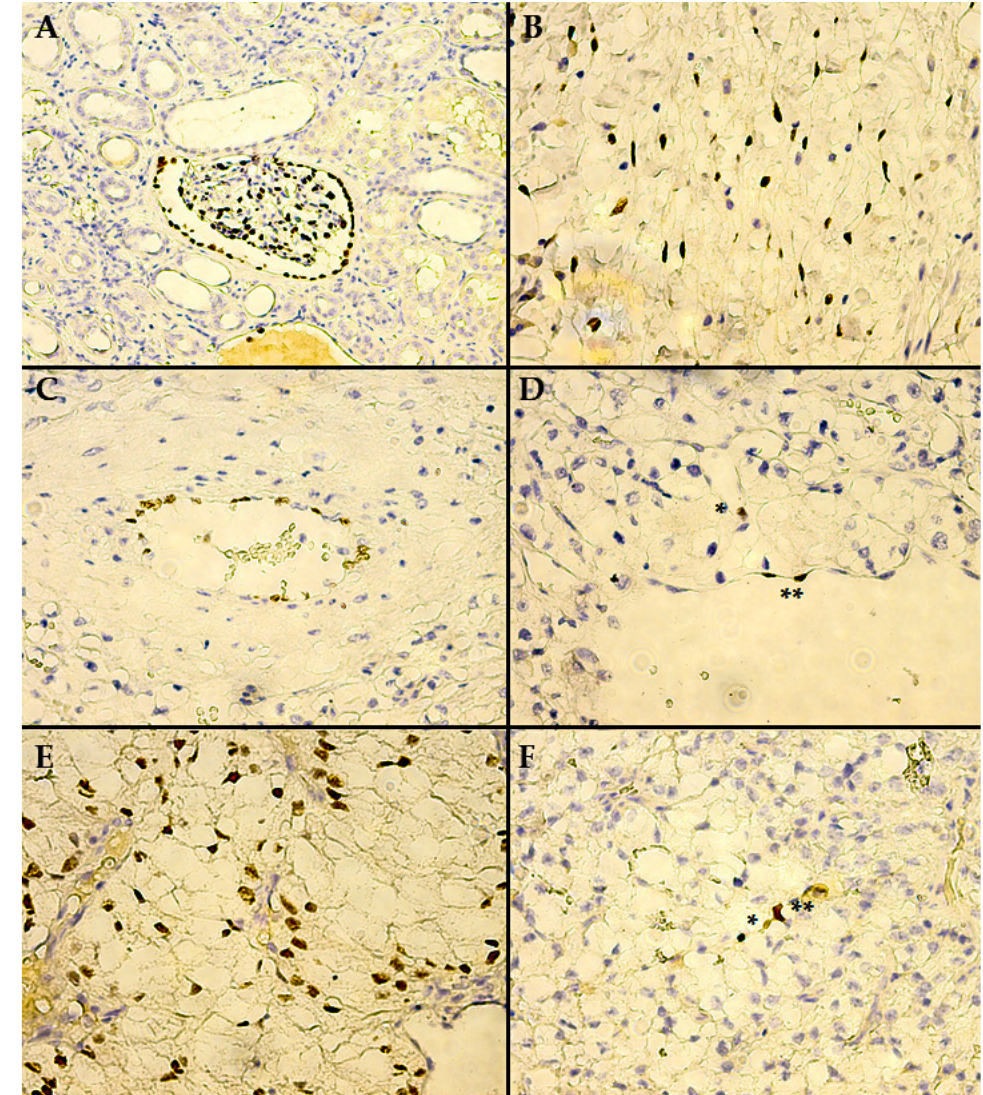
Figure 2. WT1 IHC staining : ( A ) 200×, control image of a quasi-normal positive glomerulus; ( B ) 400×, positive fusiform cells outside of the tumor tissue, with a morphology suggestive of fibroblasts/myofibroblasts; ( C ) 400×, blood vessel with a majority of endothelial cells manifesting positive nuclear staining; ( D ) 400×, large blood vessel close-up, with scarce positive endothelial cells ( ** ) and a single positive adjacent tumor cell ( * ); ( E ) 400×, moderate density of positive tumor cells (+2), manifesting predominantly high intensity nuclear staining; ( F ) 400×, low density (+1) tumor tissue, manifesting only 2 distinct positive cells, with weak-intensity ( * ) and moderate-intensity ( ** ) nuclear staining.